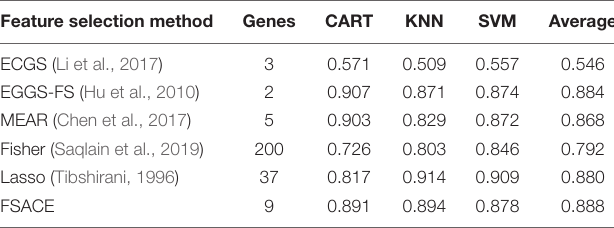
TABLE 5 | Classification accuracy of Leukemia2 using six different feature selection algorithms.